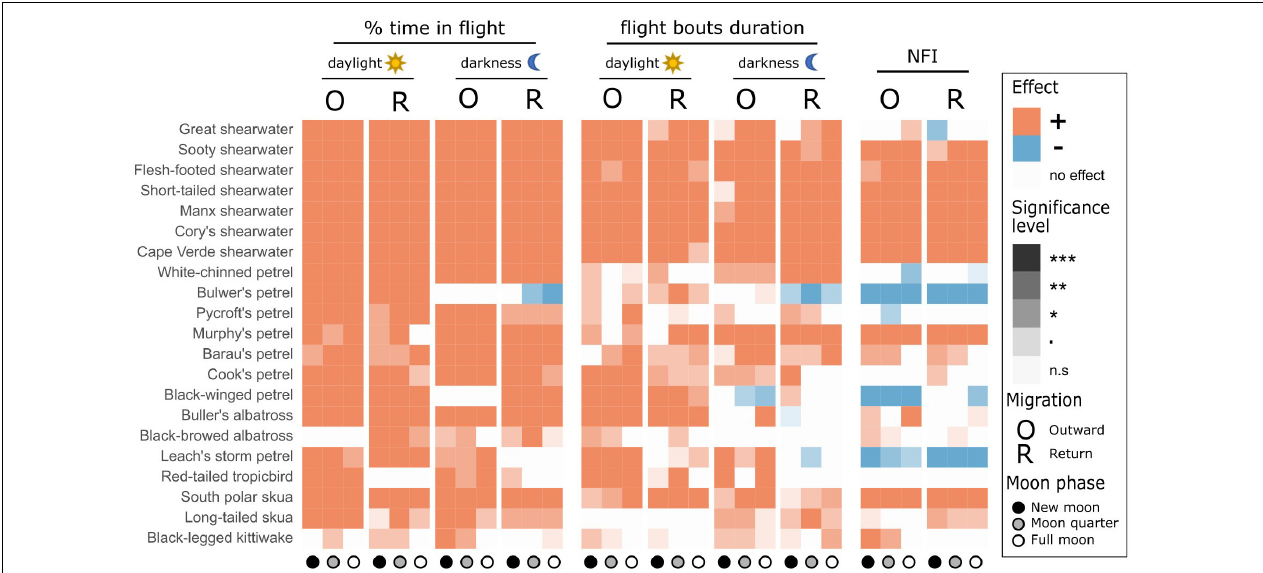
FIGURE 1 | Representation of results of LMMs testing the effect of outward (O) and return (R) migration compared with the non-breeding period on three behavioural response variables: % of time in flight, flight bout duration, and the night flight index (NFI). Orange squares indicate that the value was significantly higher during the migratory stage than during the non-breeding period, blue squares that the value was significantly higher during the non-breeding period, and white squares that there was no significant difference. Shade represents level of significance. Effects are tested separately by moon phase (new moon: dark circles, moon quarters: grey circles, full moon: white circles) and for daylight vs. darkness, as appropriate. For scientific names, see Table 1 . Significance levels: “***” = p -value < 0.001, “**” = p -value < 0.01, “*” = p -value < 0.05, “.” = p -value < 0.1, “n.s” =